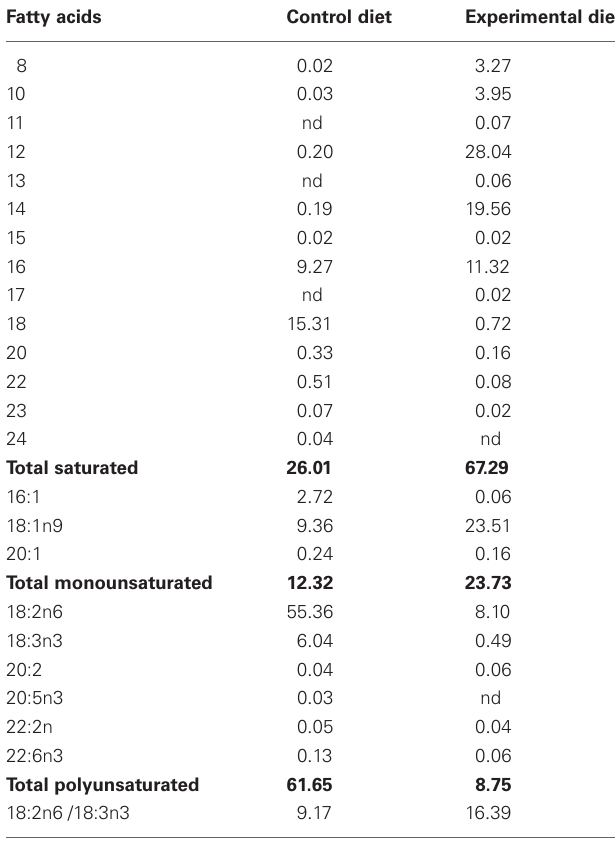
Table 2 | Fatty acid composition of the diets (% of total fatty